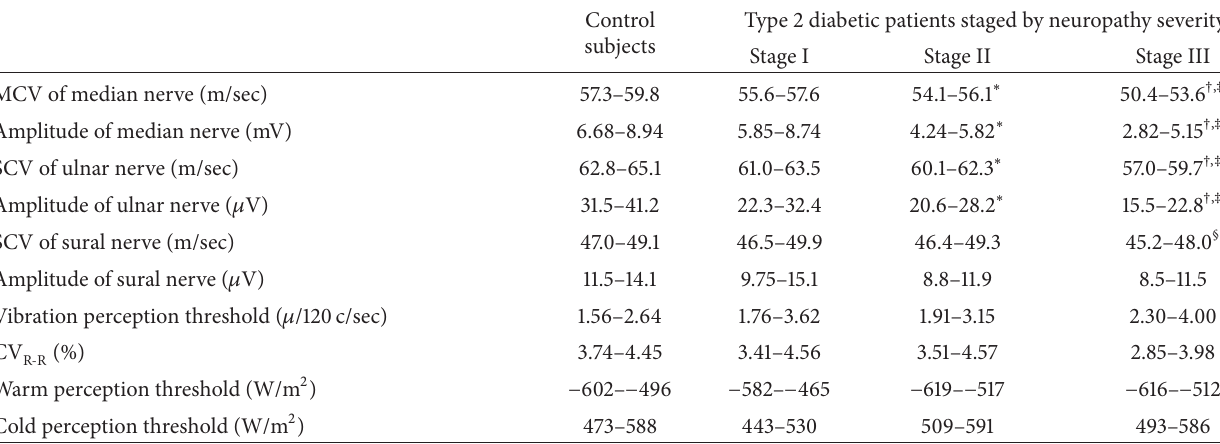
Table 2: Neurophysiological functions in control subjects and subgroups of type 2 diabetic patients stratified by the severity of